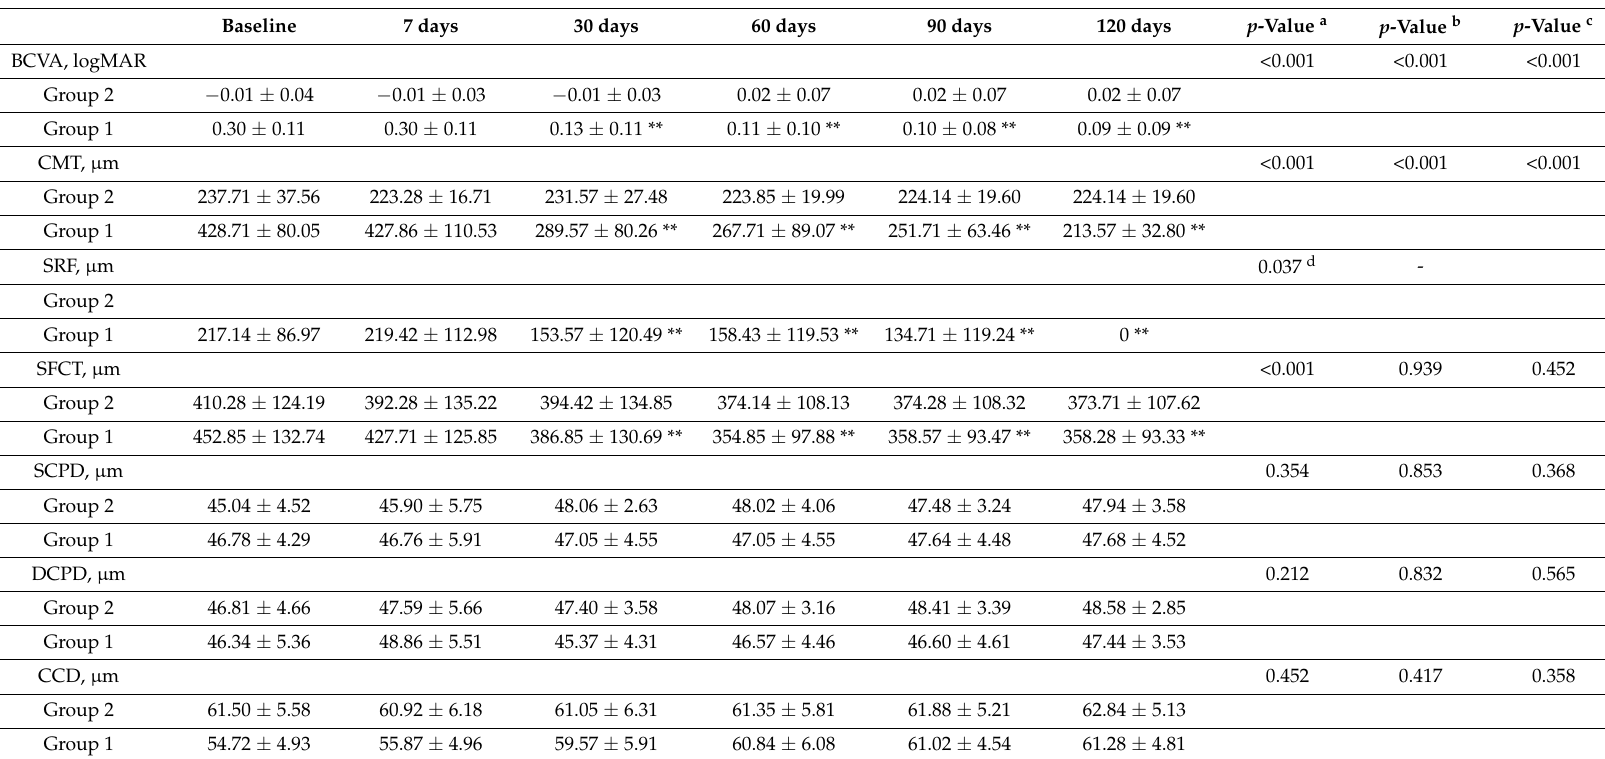
Table 2. Functional and morphological parameters at baseline and after eplerenone therapy in two